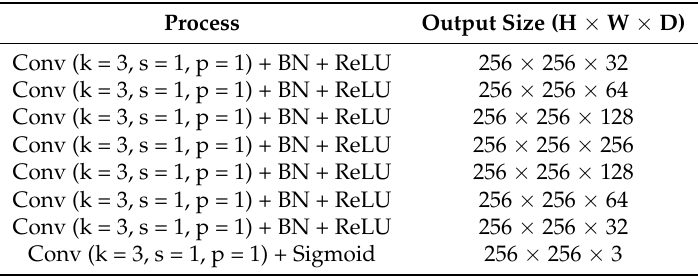
Table 2. Architechure of RevSec